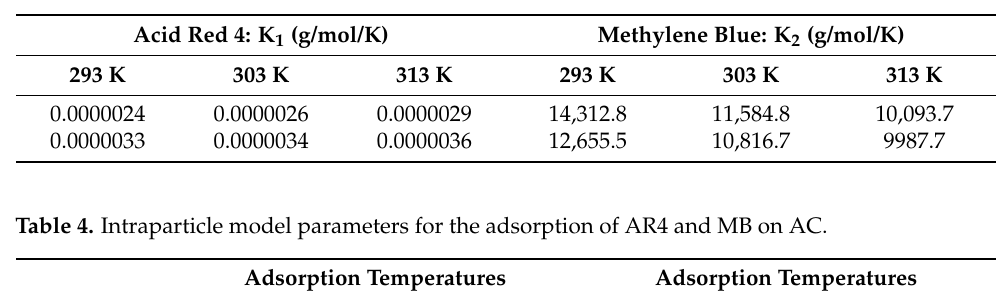
Table 3. Kinetic parameters of pseudo-first- and pseudo-second-order for the adsorption of AR4 and MB on AC at 293 K, 303 K and 313 K.